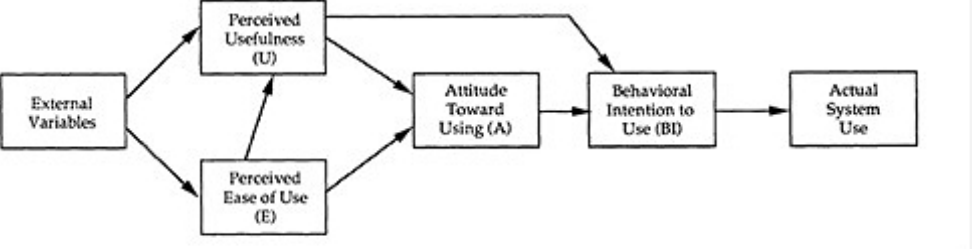
Figure 5. Technology Acceptance Model. Reprinted by permission. Copyright [1989] INFORMS. Fred D. Davis, Richard P. Bagozzi, Paul R. Warshaw (1989) User Acceptance of Computer Technology: A Comparison of Two Theoretical Models. Management Science 35(8):982-1003, the Institute